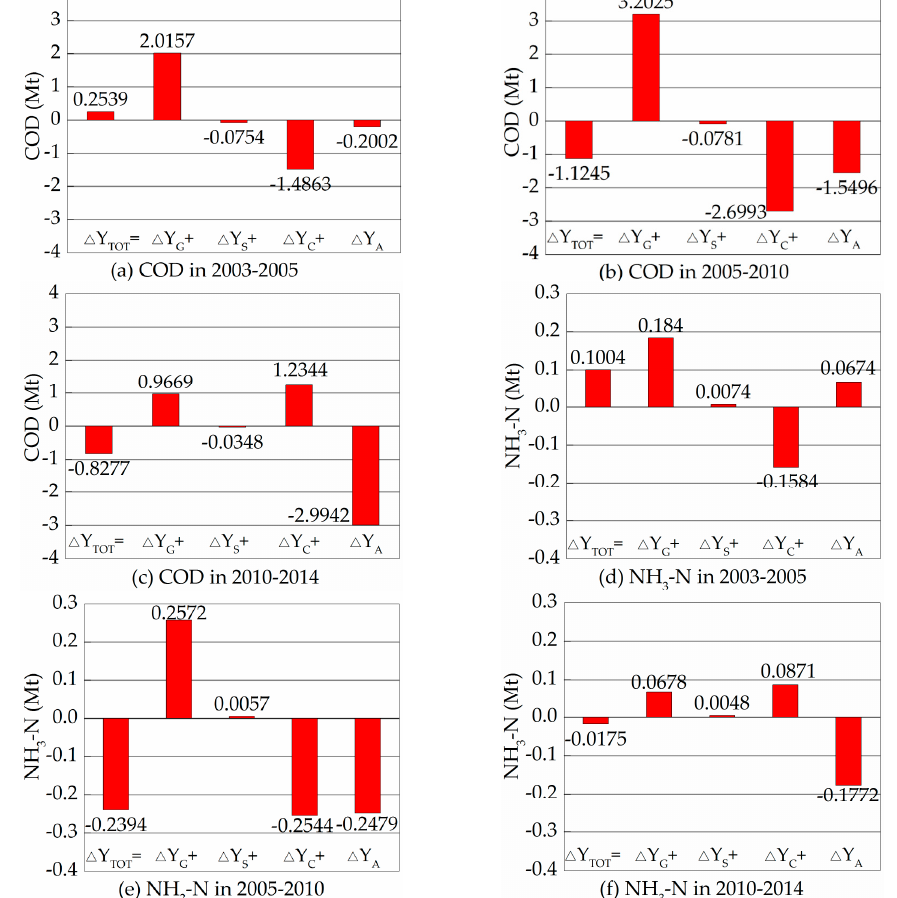
Table 1. Contributions of various factors to the changes in COD and NH 3 -N discharge (unit: %). Period